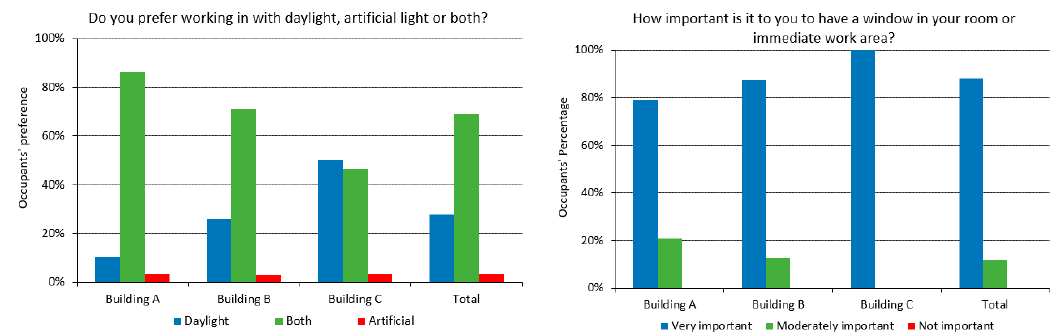
Figure 10. Results for how the users prefer their lighting conditions ( left ) and how important is for